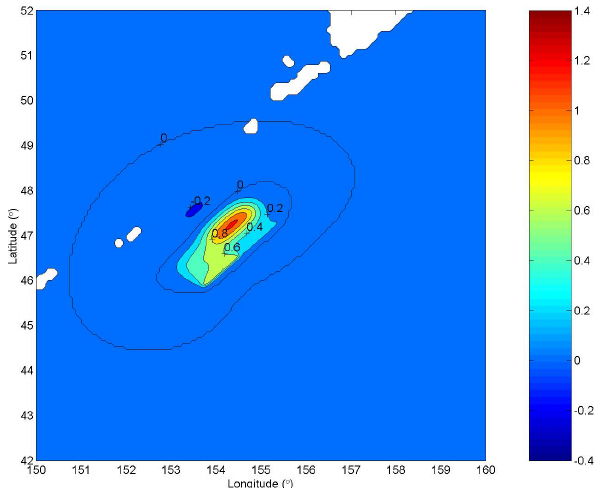
Fig. 14. Tsunami source (water surface displacement in metres) of the 15 November 2006 event near Kuril